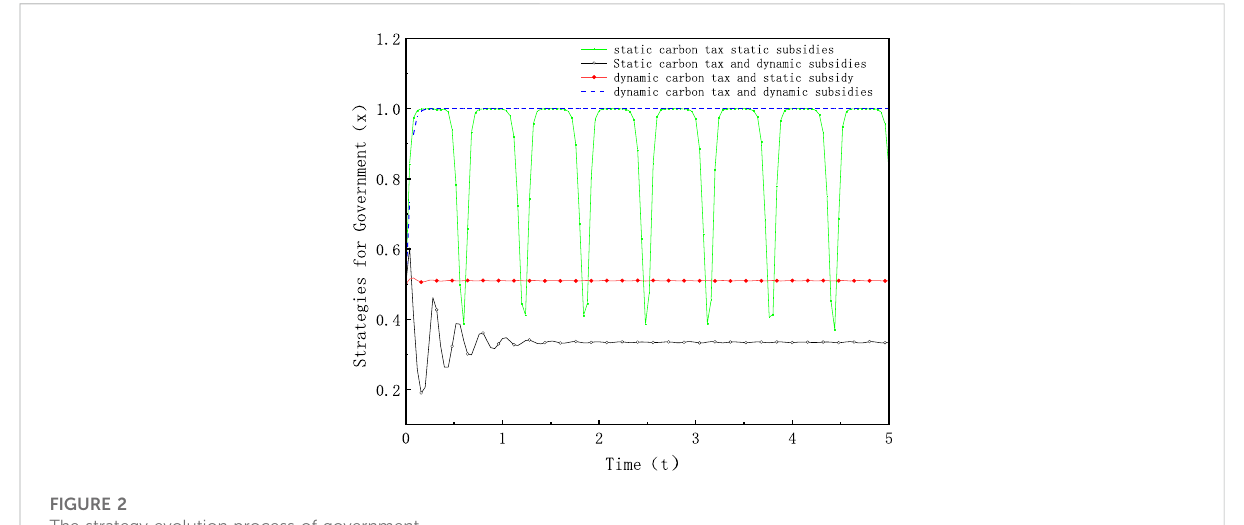
FIGURE 2 The strategy evolution process of